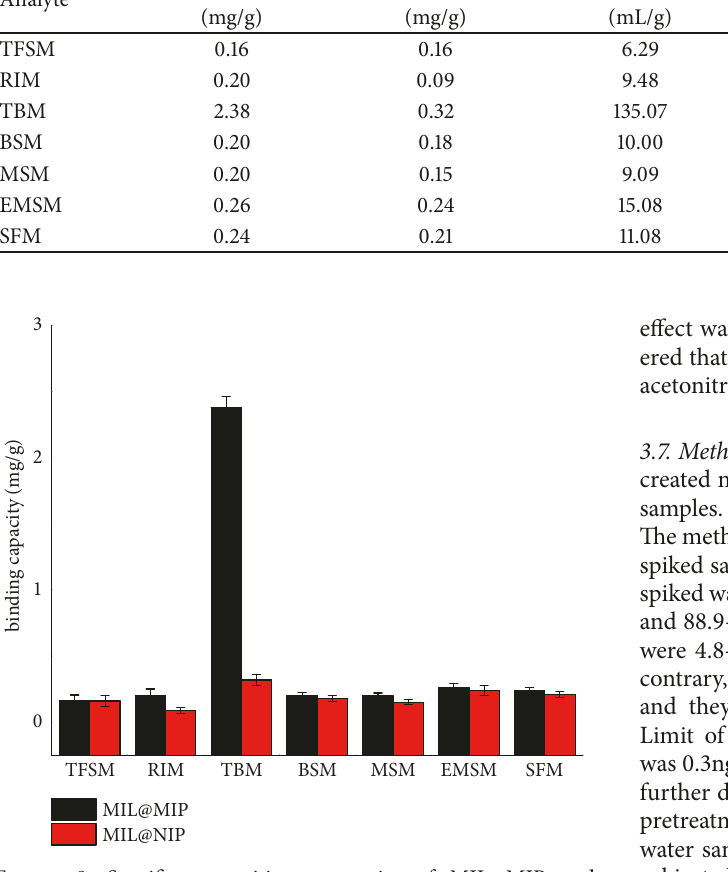
Figure 8: Specific recognition properties of MIL@MIP and